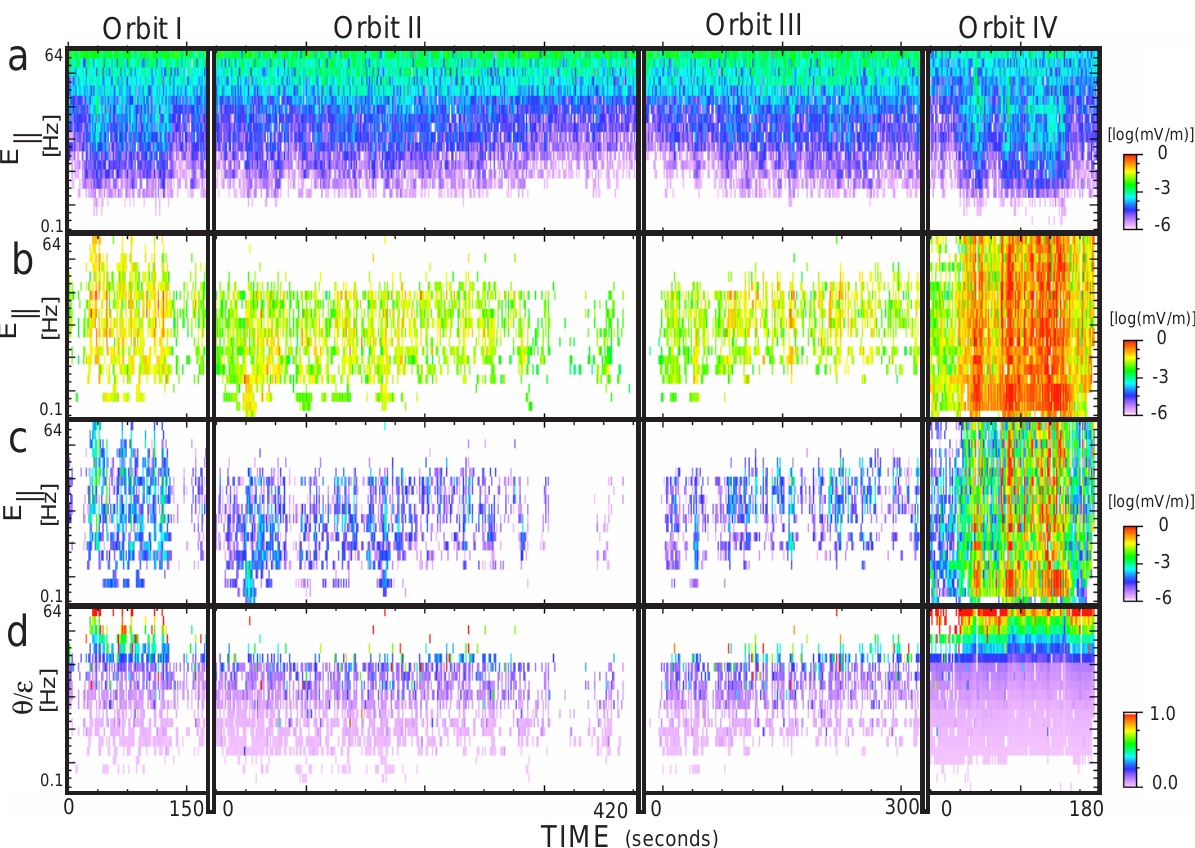
Fig. 4. The field-aligned electric field as calculated by three different methods are presented in the three top panels (see text for further details), together with the estimated propagation angle of a dispersive Alfv´en wave (last panel). Parallel electric fields of the order of 0.1–1mV/m are inferred, which can readily accelerate thermal electrons to energies of several 100eV within fractions of a second. Note the magnetometer noise level above